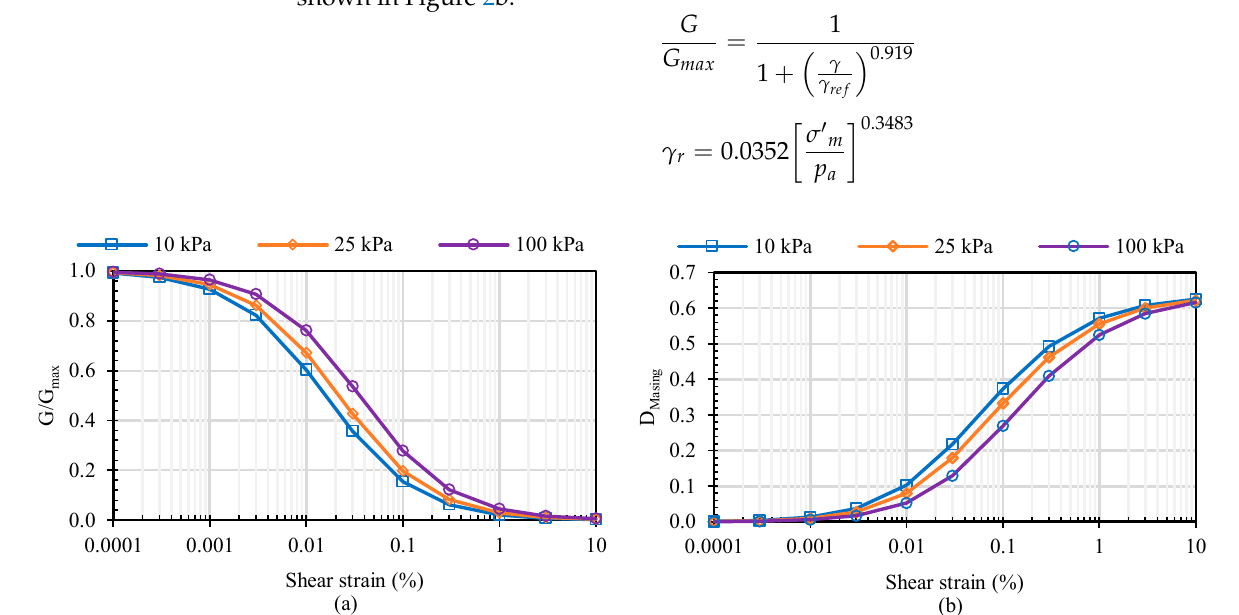
Figure 2. ( a ) Modulus degradation curves of Darendeli [14] ( b ) Masing Damping ratio curves.